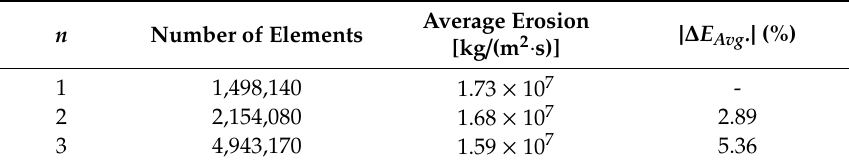
Figure 2. CFD model of the helicopter rotor blade: ( a ) boundary conditions; ( b ) mesh structure. Table 3. Results of mesh independence study. Table 3. Results of mesh independence